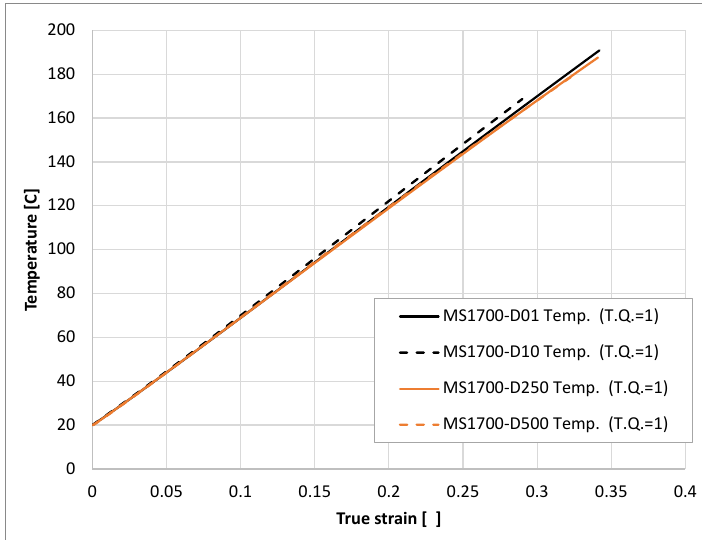
Figure 21. Temperature estimate from self-heating in dynamic tests.